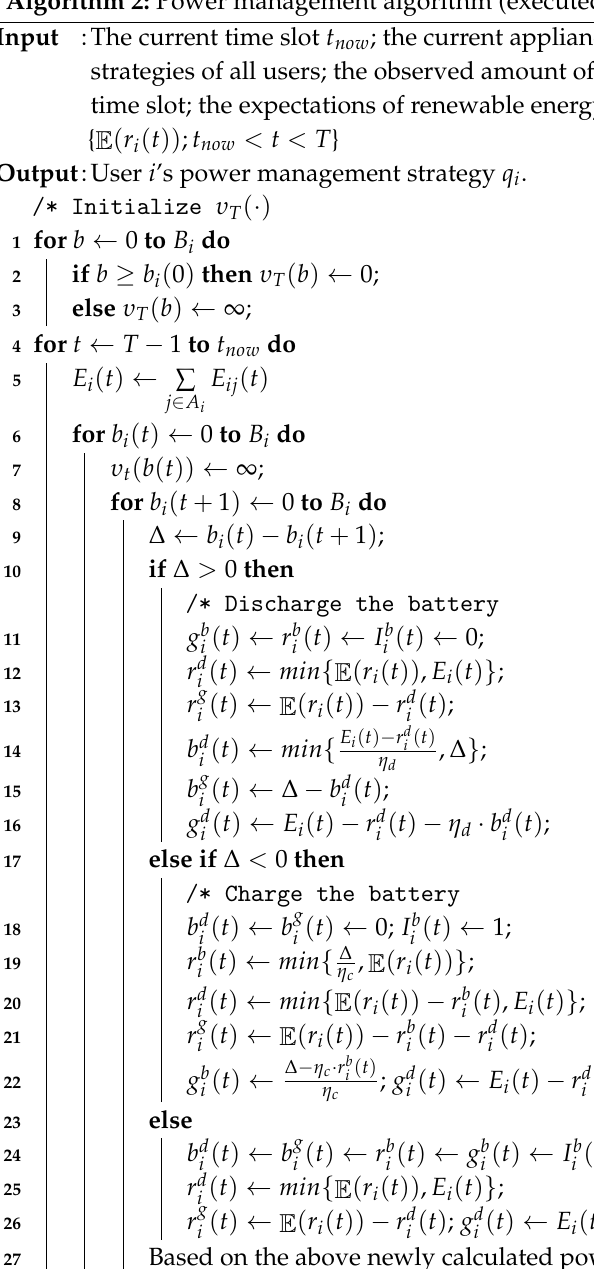
Algorithm 2: Power management algorithm (executed by each individual user i